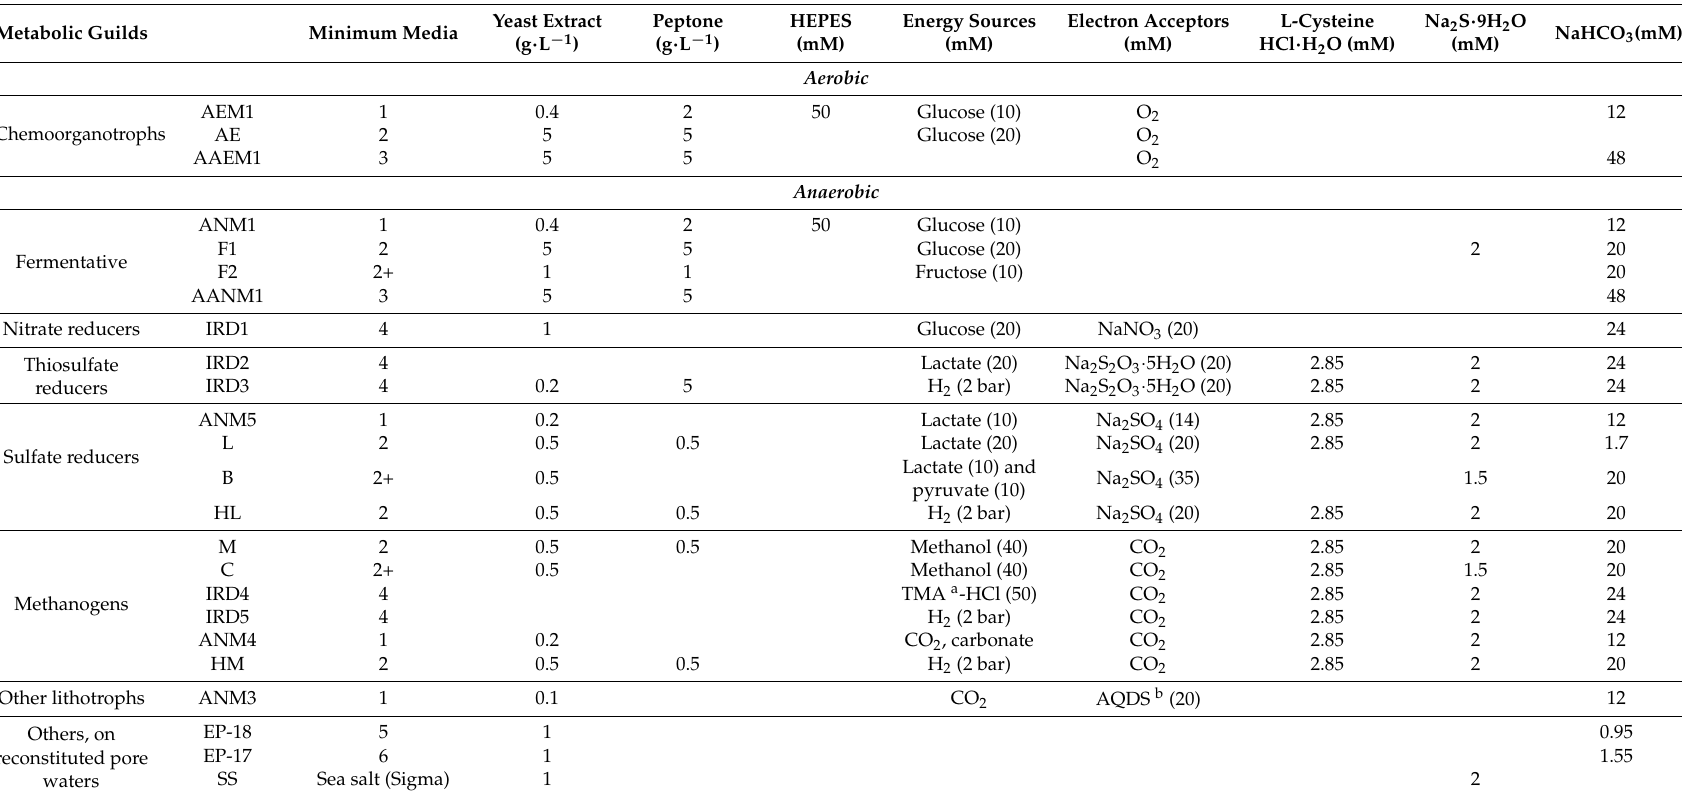
Table 1. Composition of enrichment culture media. The resazurin color indicator was added into anaerobic media (1 mg · L − 1